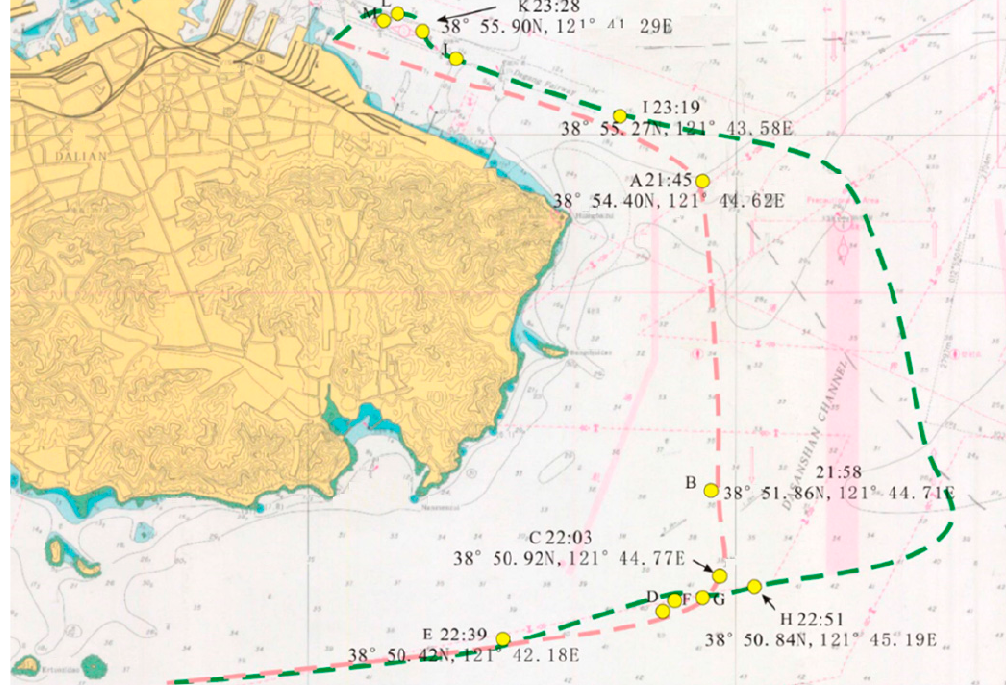
Figure 4. Overview of the oil spill cleanup mission. The red and green lines are the departure and return routes, respectively.